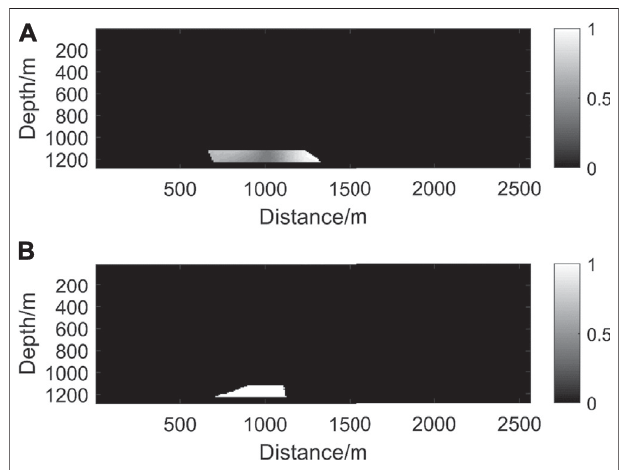
FIGURE 7 | Determination of the low illumination area. (A) The illumination results as network input. (B) The picked low illumination area as network output.